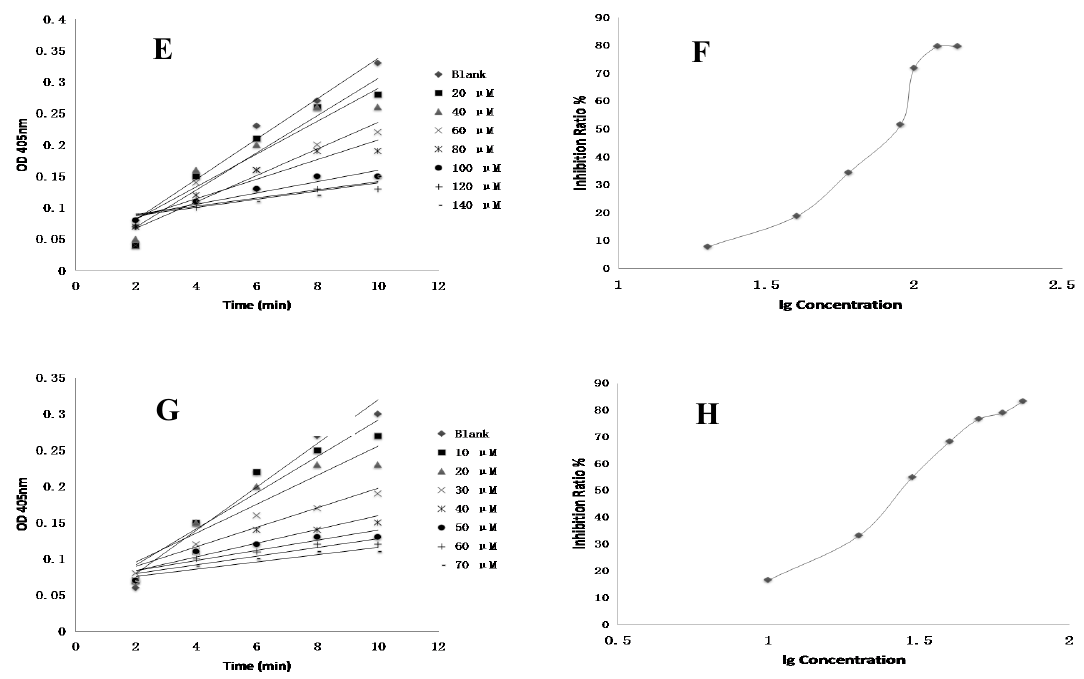
Figure 5. The inhibition profile figures of ginsenoside (Rg2) ( A , B ); ginsenoside (Rg3) ( C , D ); protopanaxtriol (PPT) ( E , F ) and Ximelagatran ( G , H ) against thrombin.